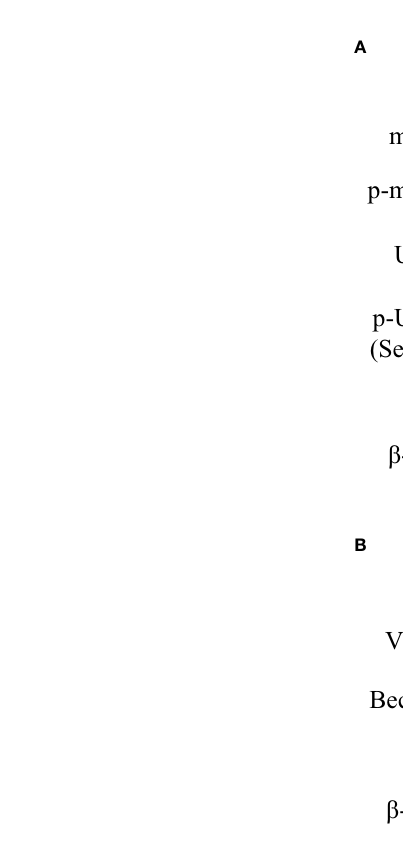
FIGURE 5 Echovirus infection induces the activation of signaling pathways involved in autophagosome formation. RD cells were infected or not (Mock) with echovirus 11 at different MOI for 1.5 h. At 16 h post-infection, cells were then harvested. (A) Intracellular mTOR, phosphorylated mTOR (p-mTOR), ULK1, phosphorylated ULK1 (p-ULK1), and viral VP1 proteins were detected via western blotting. (B) Intracellular VPS34, Beclin-1, and viral VP1 proteins were detected via western blotting. b -actin served as a loading control. This result is representative of three independent